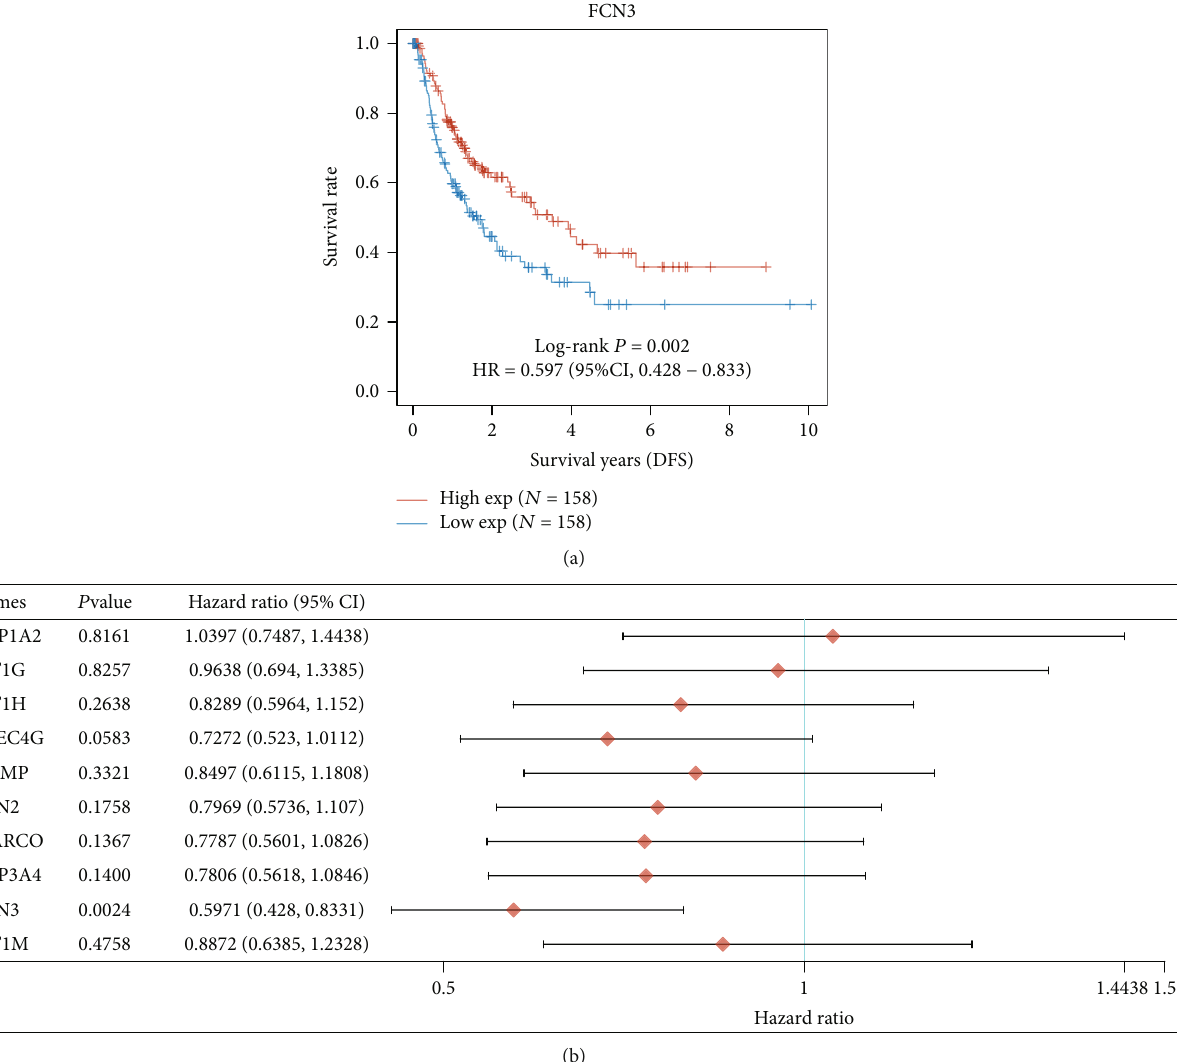
Figure 6: Identi fi cation of disease-free genes having a correlation with survival in HCC using the top 10 reduced genes. (a) Low expression of FCN3 had a correlation with poor prognosis of HCC patients. (b) Univariate Cox regression